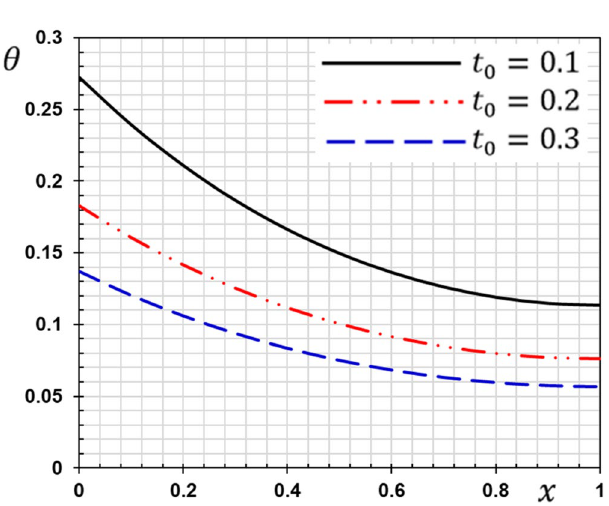
Figure 7. The influence of ramping time t 0 on the temperature.